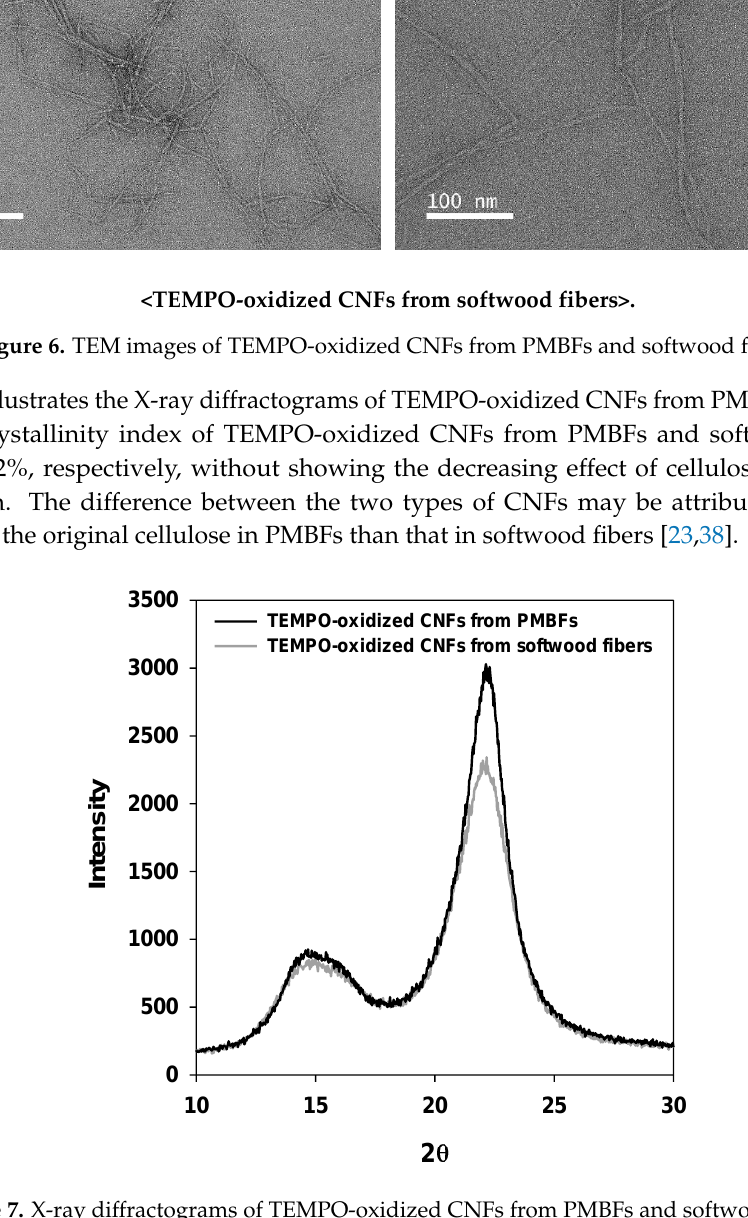
Figure 7. X-ray diffractograms of TEMPO-oxidized CNFs from PMBFs and softwood fibers.